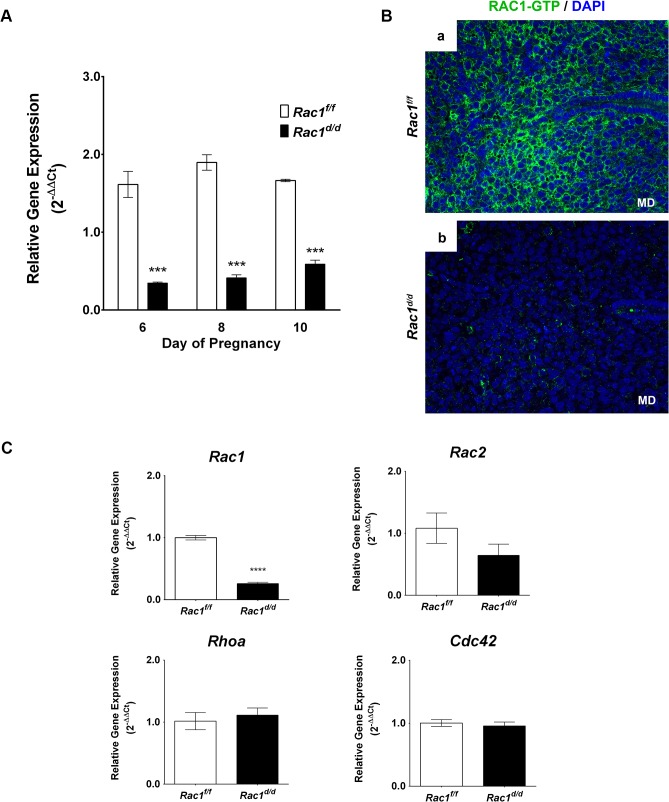
Loss of Rac1 expression in the uterus of Rac1
d/d mice.
(A) Efficient ablation of Rac1 in the uterus during decidual phase of pregnancy. Uterine RNA was purified from Rac1
f/f and Rac1
d/d mice on days 6, 8, or 10 of pregnancy and analyzed by qPCR. Relative levels of Rac1 mRNA expression in uteri of Rac1
d/d mice are compared to those in Rac1
f/f control mice. Data represent mean ± SEM from four separate samples and were analyzed by two-way ANOVA with Bonferroni post-test. Asterisks indicate statistically significant differences (***P < 0.001) (B) A marked decline in the level of active RAC1 protein in the stromal cells of Rac1
d/d uteri. Uterine sections obtained from day 8 pregnant Rac1
f/f (left panel) and Rac1
d/d (right panel) mice were subjected to IF using anti-RAC1-GTP antibody. Note the lack of RAC1 immunostaining in uteri of the mutant mice. (C) Expression of various members of the Rho family of GTPases was unaffected in Rac1
d/d uteri. Real-time PCR was performed to monitor the expression of Rac1, Rac2, Rhoa, and Cdc42 in the uteri of day 8 pregnant Rac1
f/f and Rac1
d/d mice. Data represent mean ± SEM from four separate samples and were analyzed by t-test. Asterisks indicate statistically significant differences (****P < 0.0001).